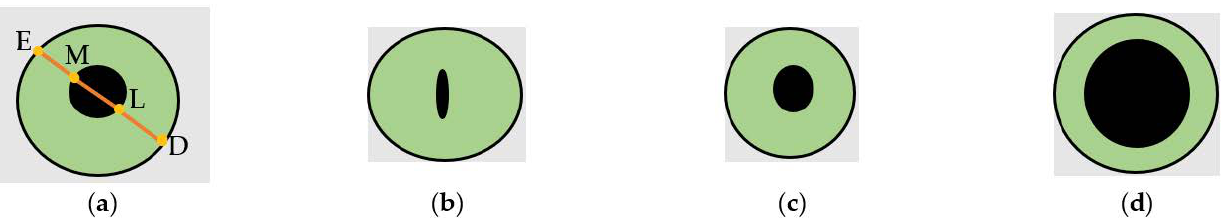
Figure 5. ( a ) Pupil dilation score. Eye width (DE) divided by pupil size (LM). ( b ) Example of small pupil. ( c ) Example of medium pupil. ( d ) Example of large